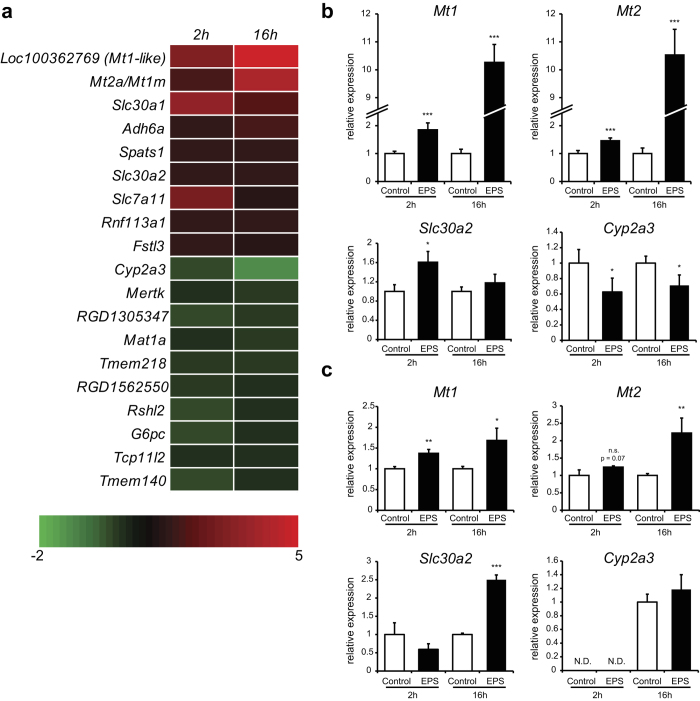
EPS conditioned medium alters gene expression in FAO hepatocytes and primary rat hepatocytes.A: Affymetrix microarray analysis of FAO hepatocytes stimulated with C2C12 conditioned media (CM). Four individual experiments were performed and the genes significantly (p < 0.05) up- and down-regulated (up, FC > 1.15; down, FC < −1.15) after both 2 h and 16 h stimulation are depicted. Inductions shown are compared to 2 hour and 16 hour stimulation with CM without EPS. Color scale ranges from a signal log ratio of −2 (green) to 5 (red). B: Relative gene expression of Mt1, Mt2, Slc30a2 and Cyp2a3 in FAO hepatocytes measured by RT-PCR. C: Relative gene expression of Mt1, Mt2, Slc30a2 and Cyp2a3 in primary rat hepatocytes measured by RT-PCR. (B-C) Error bars represent SD values of biological triplicates. * = p < 0.05; ** = p < 0.01; *** = p < 0.001 compared to CM without EPS at the same time point.